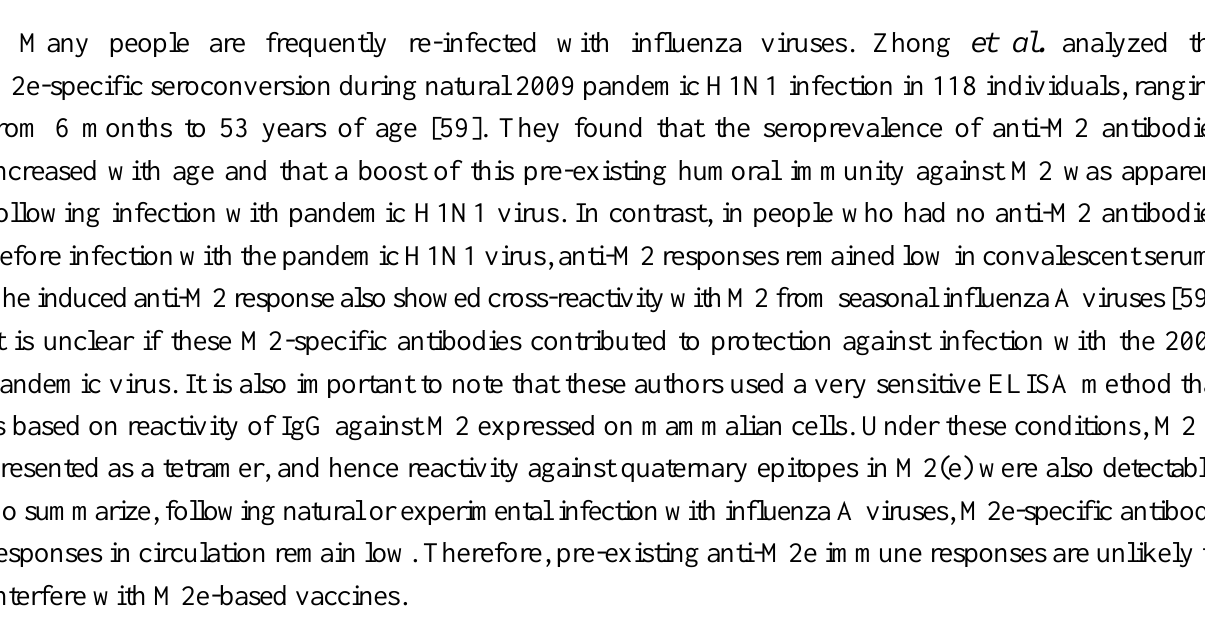
Figure 2. M2 from PR8 virus with the identified human T cell epitopes